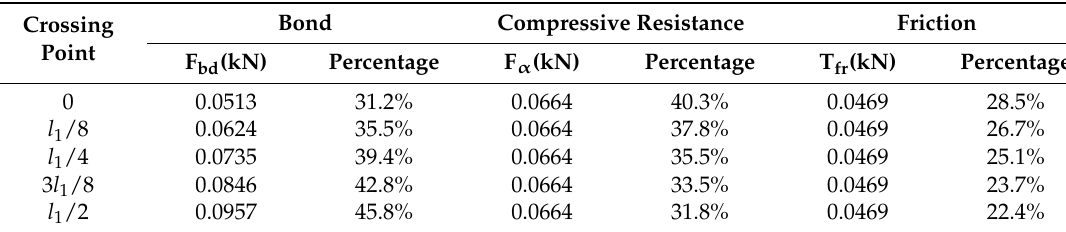
Table 3. Quantification of the influence of the mechanisms that resist the crack